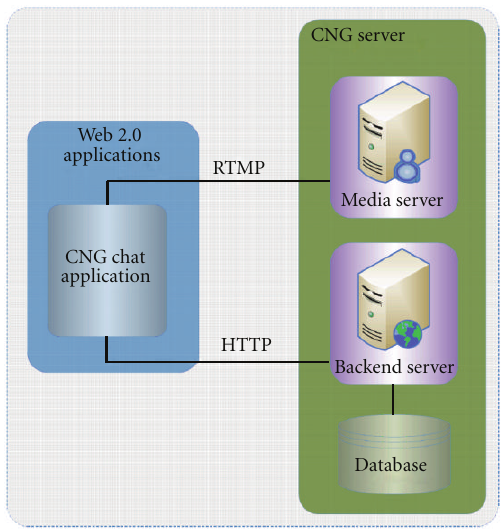
Figure 6: Overview of the interfaces for CNG chat